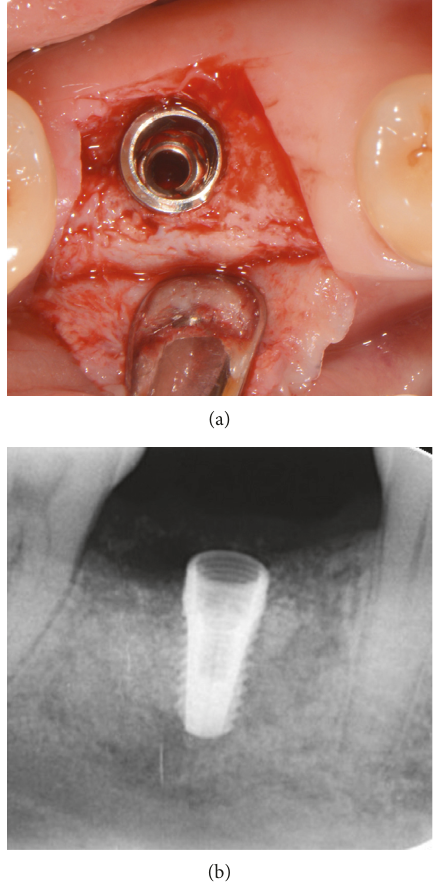
Figure 8: Implant placement at the optimal